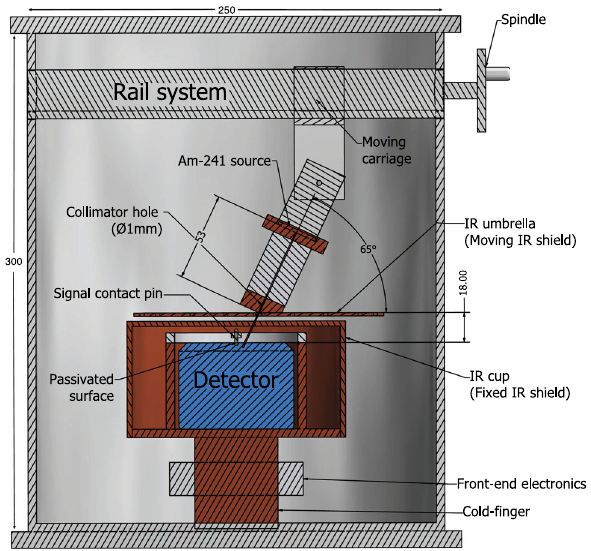
Fig. 2 A simplified cross-sectional view of the TUBE scanner, show- ingkeydimensionsinmillimeters.Detailsofthedetectorcup,front-end electronics, and cold-finger are removed for clarity. Both the detector holder (unlabeled) and the IR cup are held at the ground potential, with an insulating spacer placed between the detector holder and the n + surface of the detector, which is at high voltage